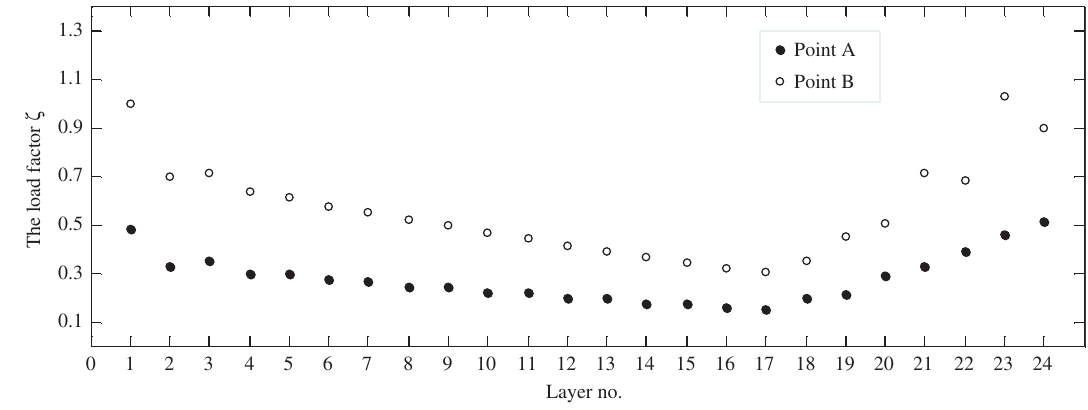
Figure 10: The load factor ζ of each layer at points A and B.